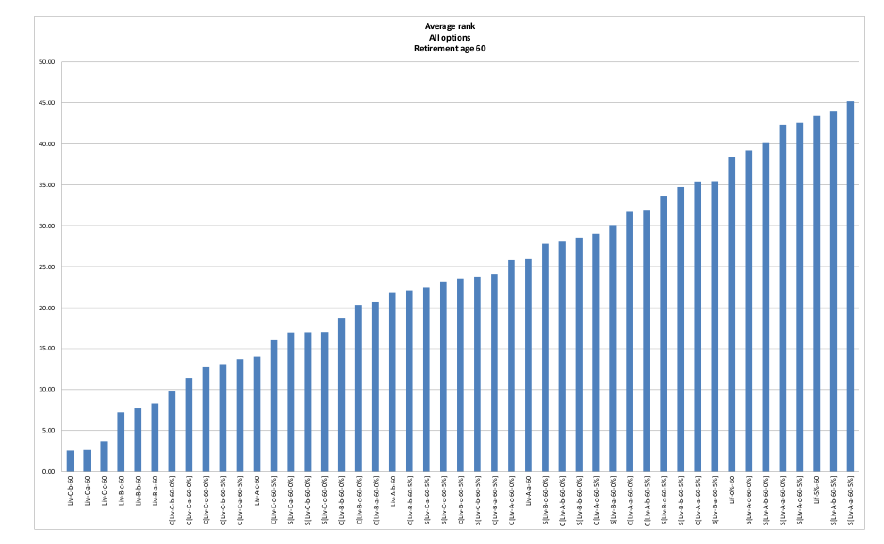
FIGURE 2: Average rank for all annuity strategies for a male retiree aged 60 Source: Authors, 2012